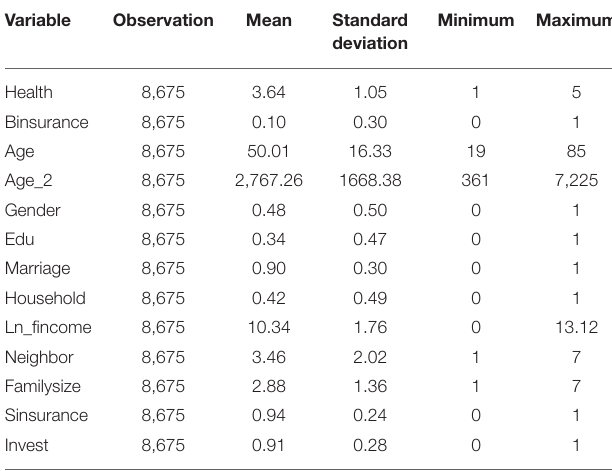
TABLE 2 | Descriptive statistics of